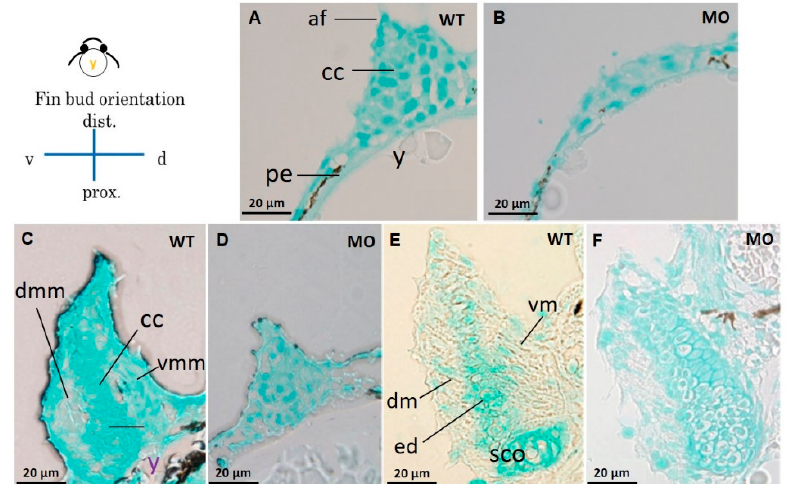
Figure 4. Cross section of pectoral fins stained with Alcian blue. Wild-type embryos showed well-developed apical folds and organized chondrocytes at 37 ( A ), 48 ( C ), and 72 hpf ( E ). The tbx5a morphant showed severe pectoral fin hypoplasia with loss of the apical fold, reduced chondrocytes, unorganized chondrogenic condensation and endoskeletal disc at 37 ( B ), 48 ( D ), and 72 hpf ( F ). (af, apical fold; cc, chondrogenic condensation; dm, dorsal musculature; dmm, dorsal myogenic mesenchyme; ed. endoskeleton disc; vm, ventral musculature; vmm, ventral myogenic mesenchyme; pe, peritoneal epithelium; y, yolk).